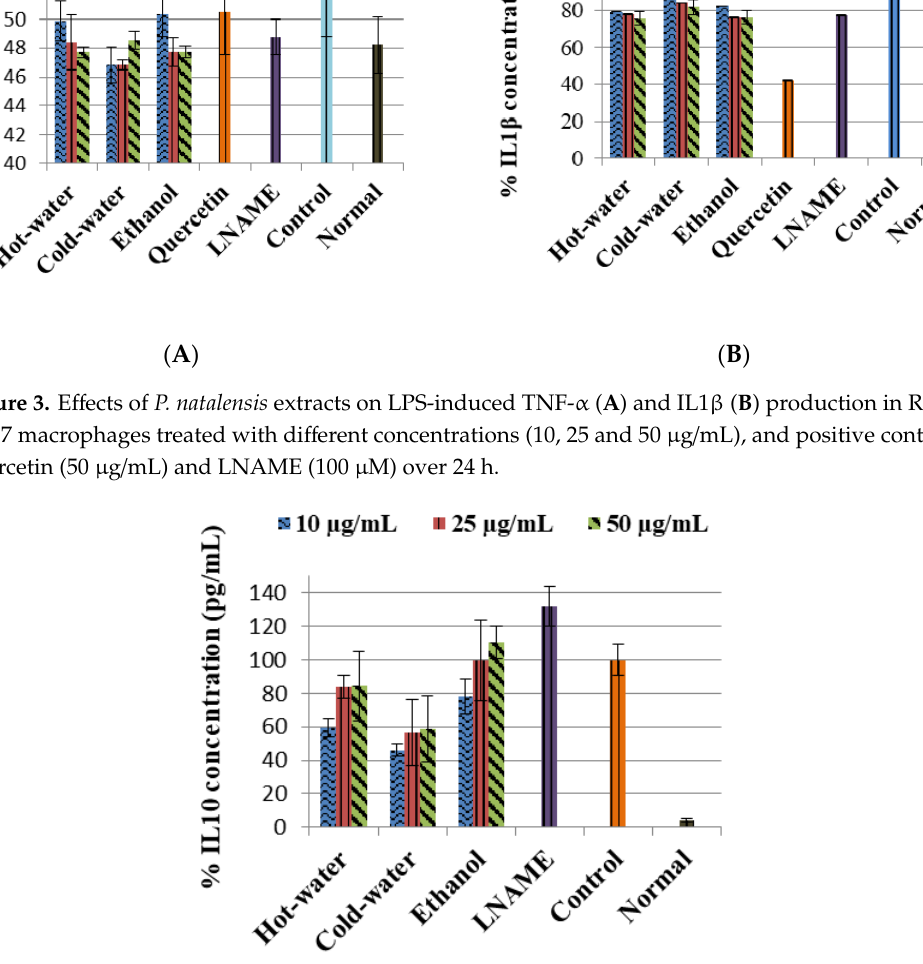
Figure 4. Effects of P natalensis extracts on LPS-induced IL10 production in RAW 264.7 macrophages treated with different concentrations (10, 25 and 50 µg/mL) and positive control LNAME (100 µM) over 24 h.